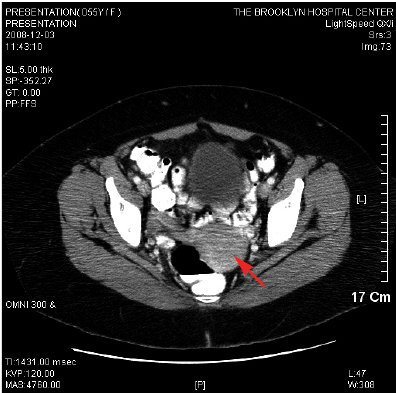
Figure 3. Computerized tomography scan of the pelvis showing soft tissue enhancement measuring 6x5.6 cm in the left wall of the vagina (arrow) consistent with metastatic clear cell carcinoma of the vagina.